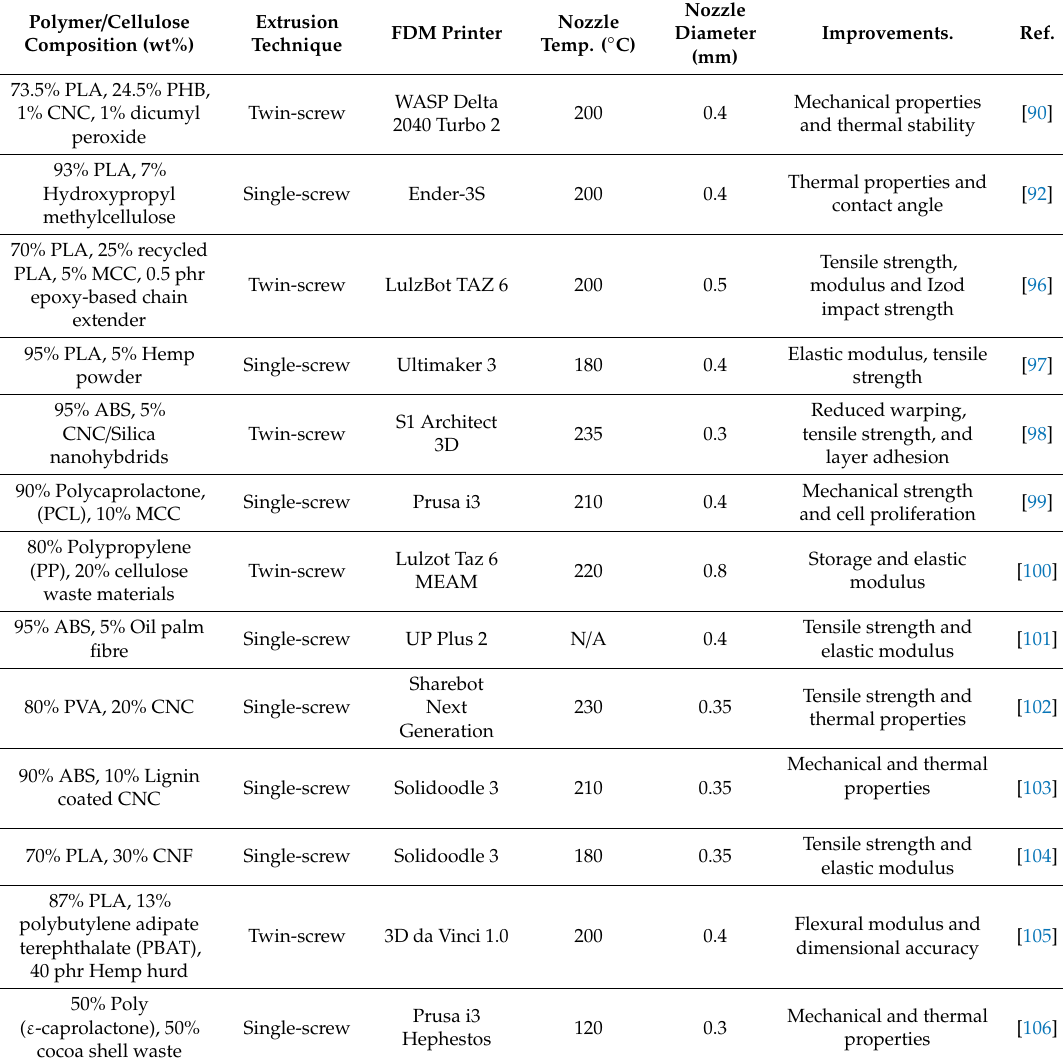
Table 3. Recent findings on the cellulose composited in thermoplastic filament for FDM extrusion. Polymer / Cellulose Composition